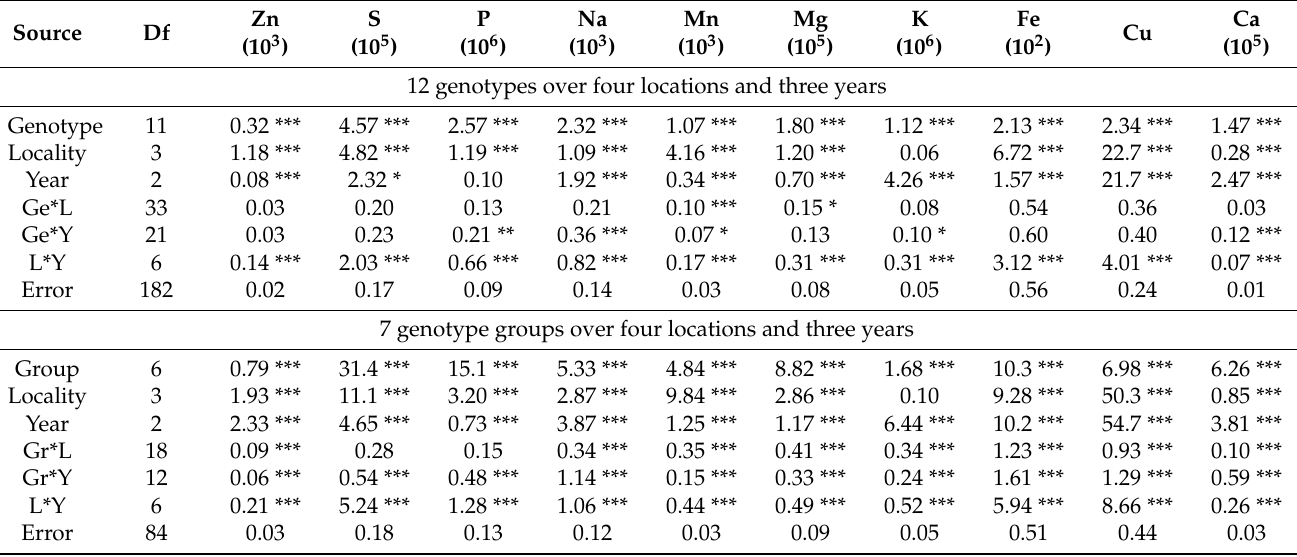
Table 3. Mean squares from the general linear model analyses (GLM) for 12 genotypes and analyses of variance (ANOVA) for seven genotype groups indicating impact on minerals content from genotypes (Ge), Genotype groups (Gr), localities (L), years (Y) and their interactions.